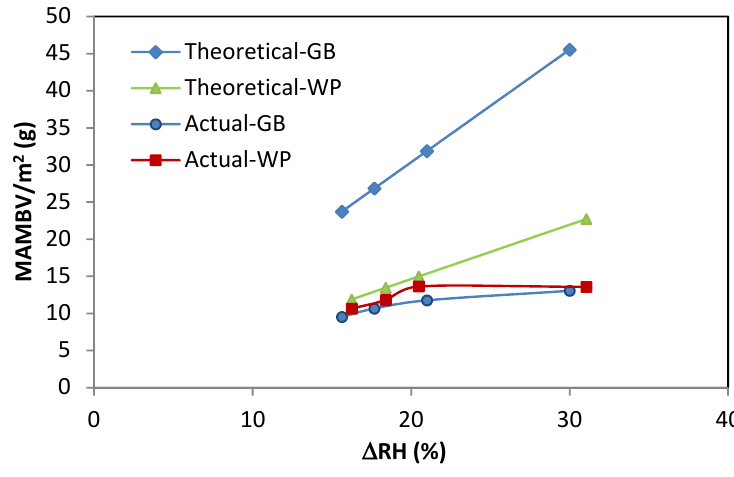
Figure 12. Relation between the MAMBV/m 2 and the RH amplitude for both uncoated gypsum board and the wood paneling under ideal and realistic